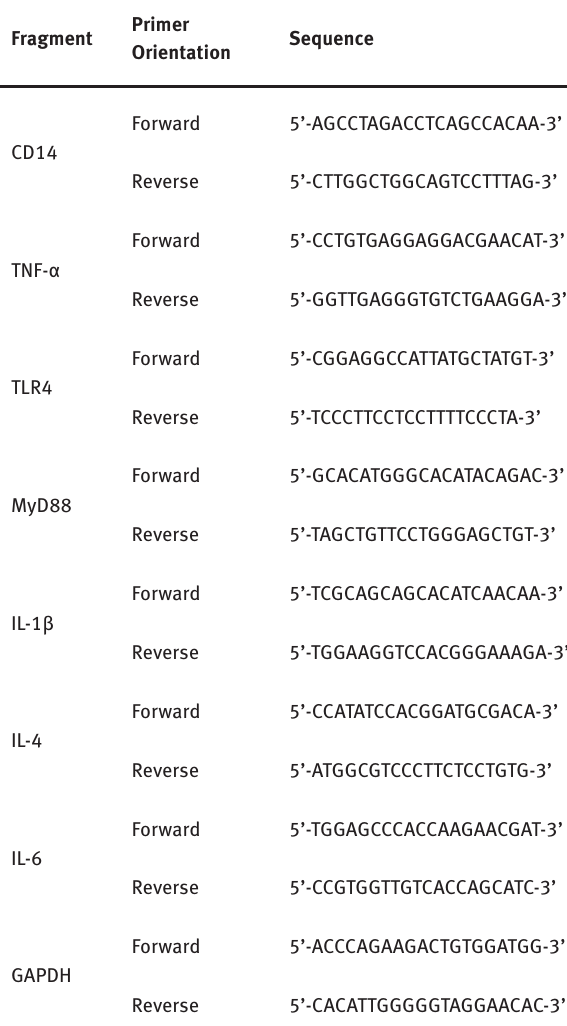
Table 1: Primers used in the experiments.